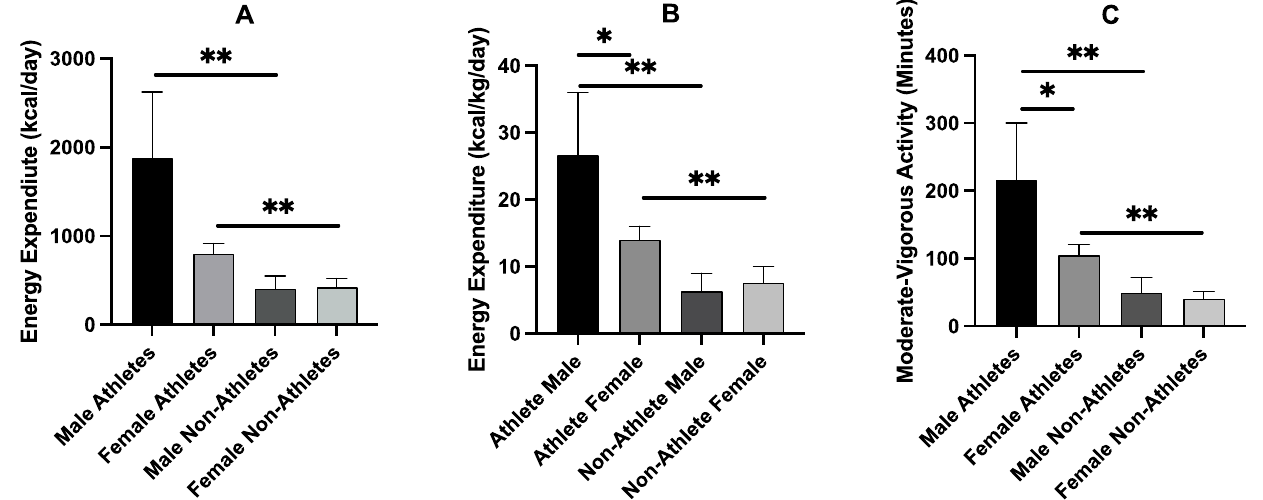
Figure 1. Absolute energy expenditure ( A ), relative energy expenditure ( B ), and moderate-vigorous activity ( C ) in male and female athletes ( n = 13 and n = 45, respectively) and nonathletes ( n = 13 and n = 45, respectively). Values are means ± SD. * denotes p < 0.05 difference; ** denotes p < 0.001 dif- ferences.